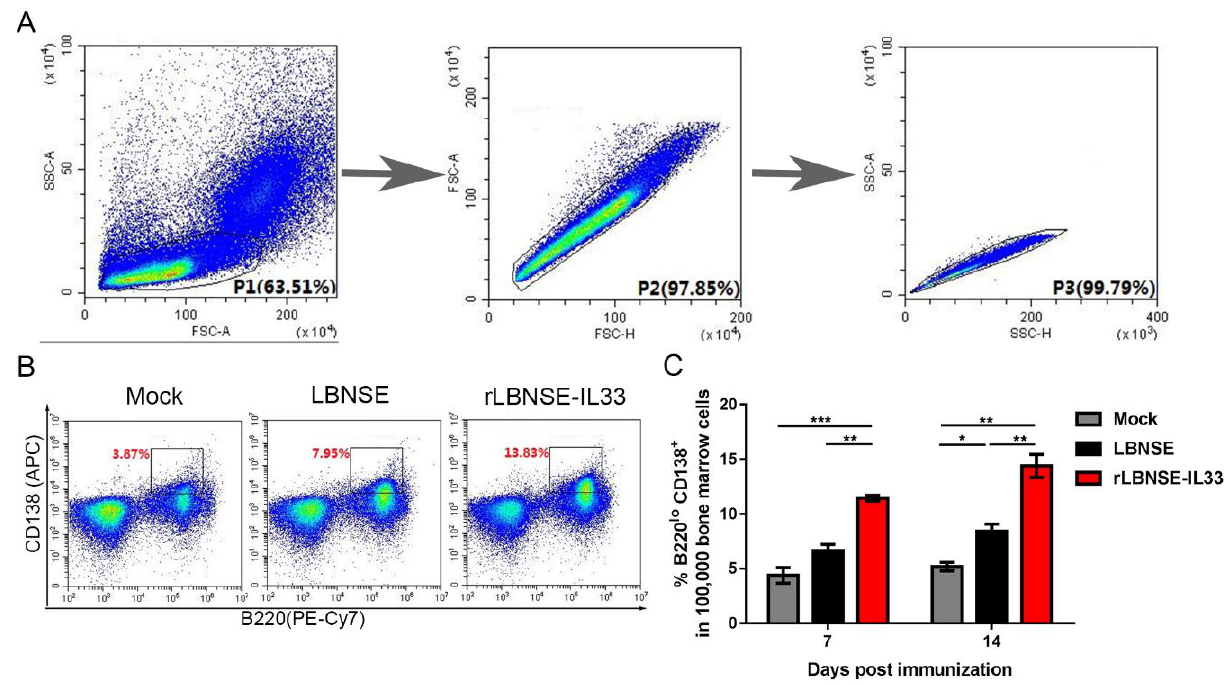
Figure 8 . Overexpression of IL-33 in rRABV increases the PC number. Six-week-old female BALB/c mice were infected with LBNSE (10 6 FFU), rLBNSE-IL-33 (10 6 FFU), or DMEM (as mock) and their BM cells were collected at 7 and 14 dpi: ( A ) gating strategies and contour plots of lymphocytes in BM cells; ( B ) flow cytometric analysis of PCs (B220 lo CD138 + ) in the lymphocytes of BM cells; ( C ) percentage of PCs per 10 5 BM cells at 7 and 14 dpi. The standard error (SE, n = 3) was illustrated by error bars, and the data were analyzed by unpaired two-tailed t-test. Significant differences between groups were indicated at three levels: *, p < 0.05; **, p < 0.01; and ***, p < 0.001.